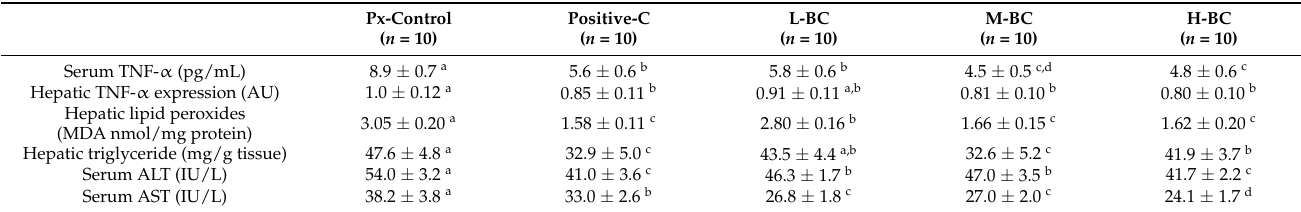
Table 4. Triglyceride contents, inflammation, and oxidative stress indexes in the liver.